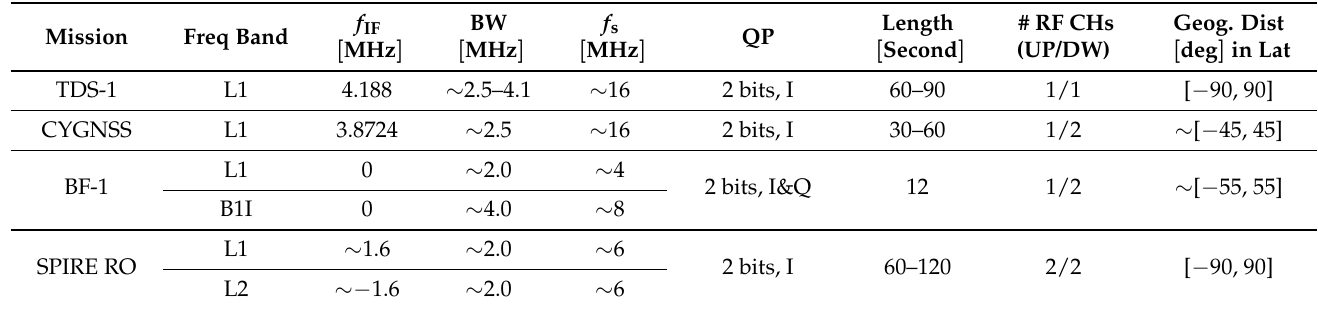
Table 1. Configurations of Raw IF Data Collection From Different GNSS-R Missions. f IF :